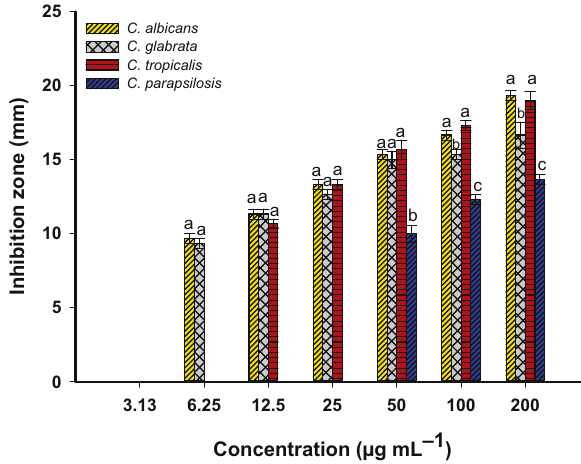
Figure 6: Activity of CuO - NPs against clinical pathogens C. albicans , C. glabrata , C. tropicalis , and C. parapsilosis at di ff erent concen - trations ( 200, 100, 50, 25, 12.5, 6.25, and 3.13 µg · mL – 1 )